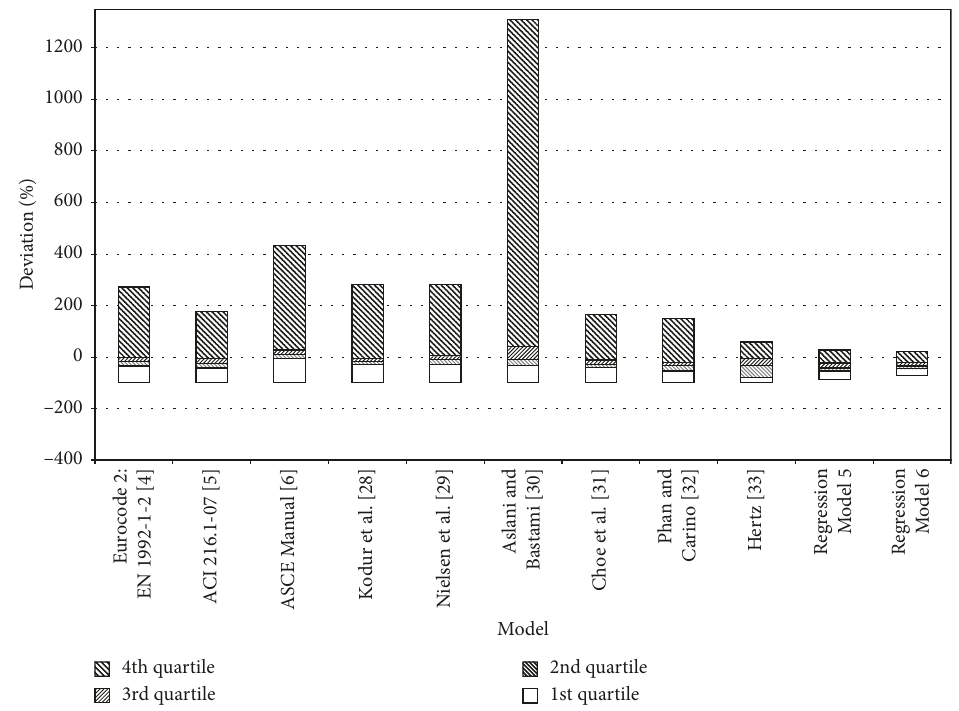
Figure 12: Spread of error percentiles for different